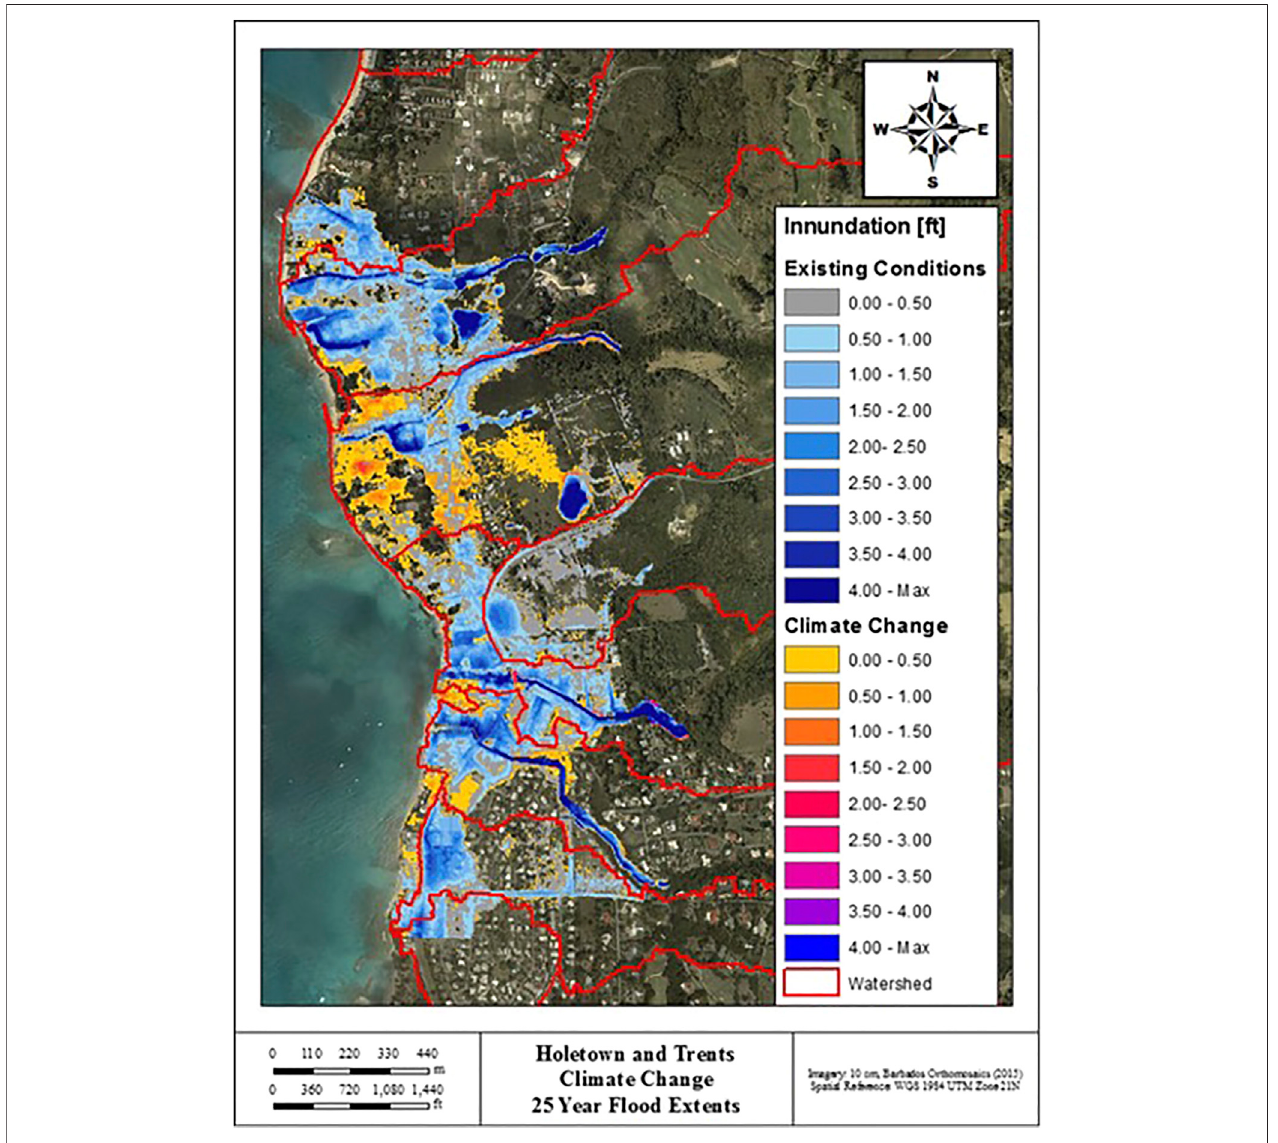
FIGURE 2 | Low Elevation Coastal Zone and Flooding in Holetown and Trent based on Climate Change Scenarios (source: Baird 2016).